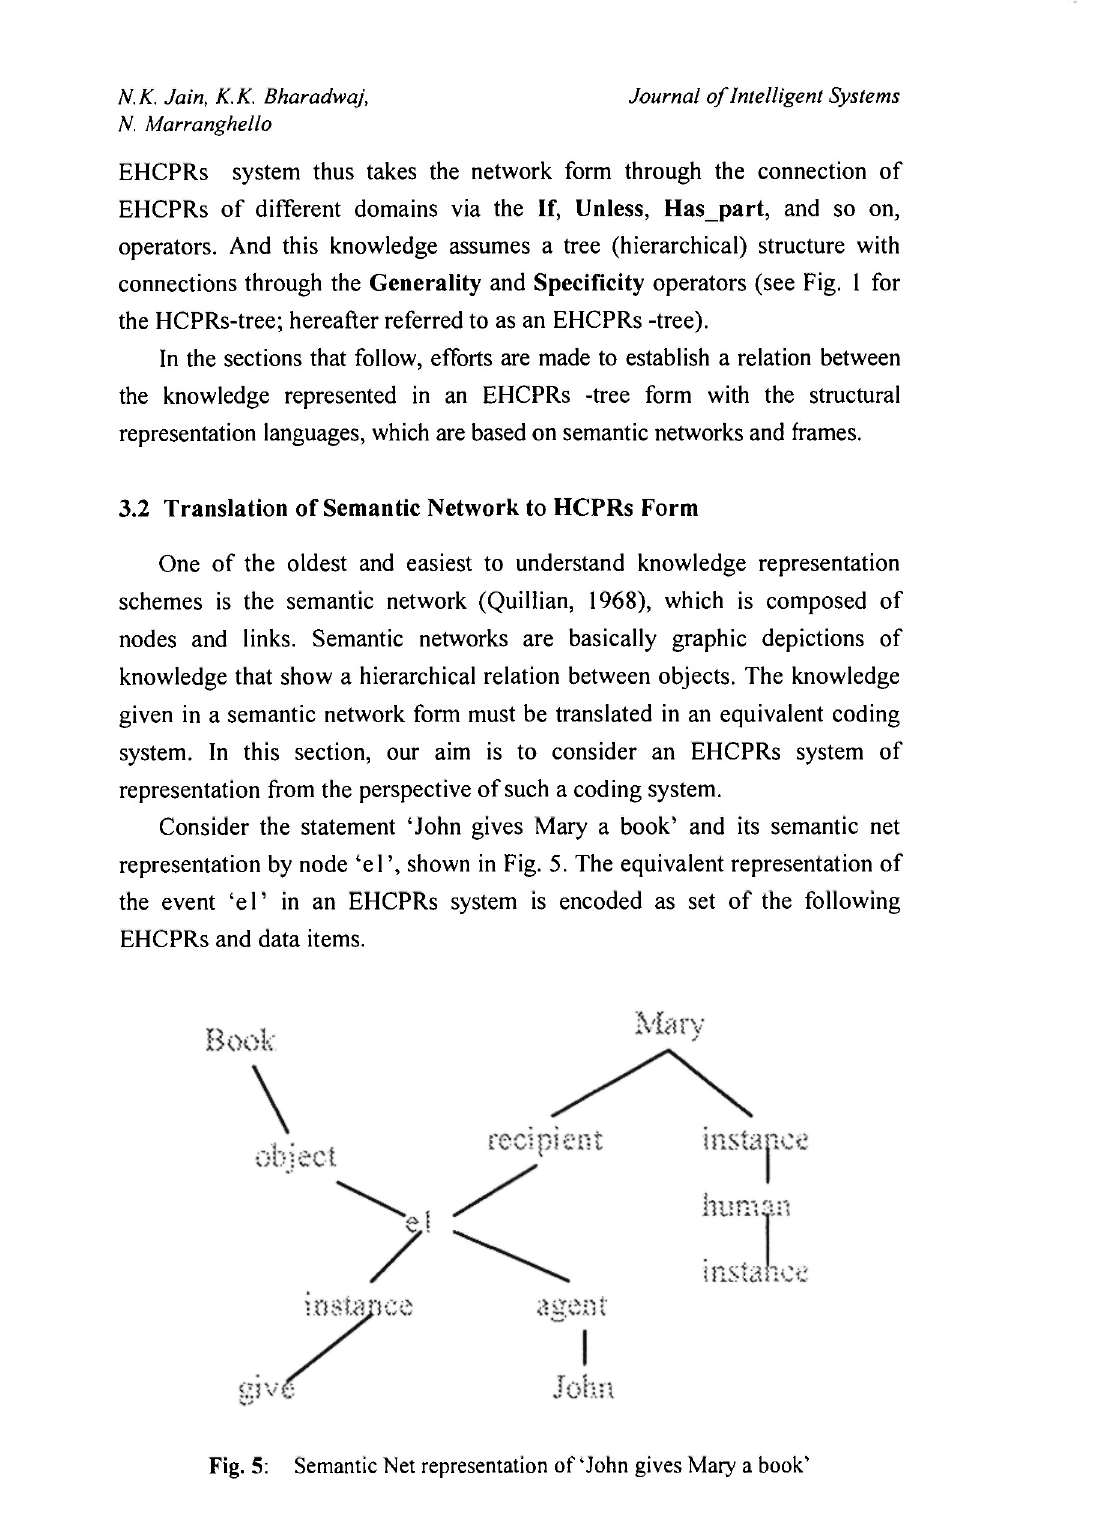
Fig. 5: Semantic Net representation of 'John gives Mary a book'